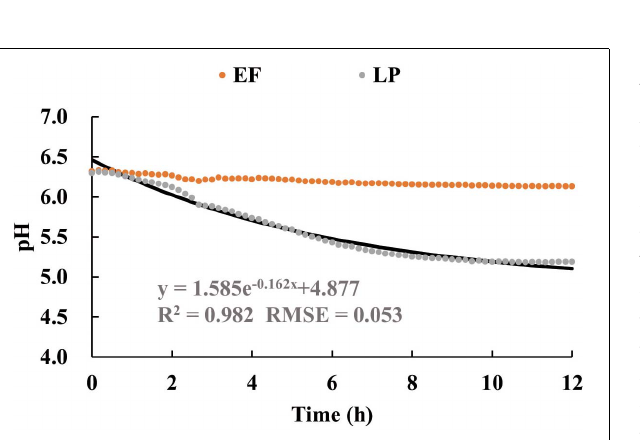
FIGURE 8 | Effect of pH on the rate of microbial respiration in relation to (cid:49) CO 2 with pH < 5 (A) , (cid:49) CO 2 with pH ≥ 5 (B) , (cid:49) EtOH with pH < 5 (C) , and (cid:49) EtOH with pH ≥ 5 (D) .